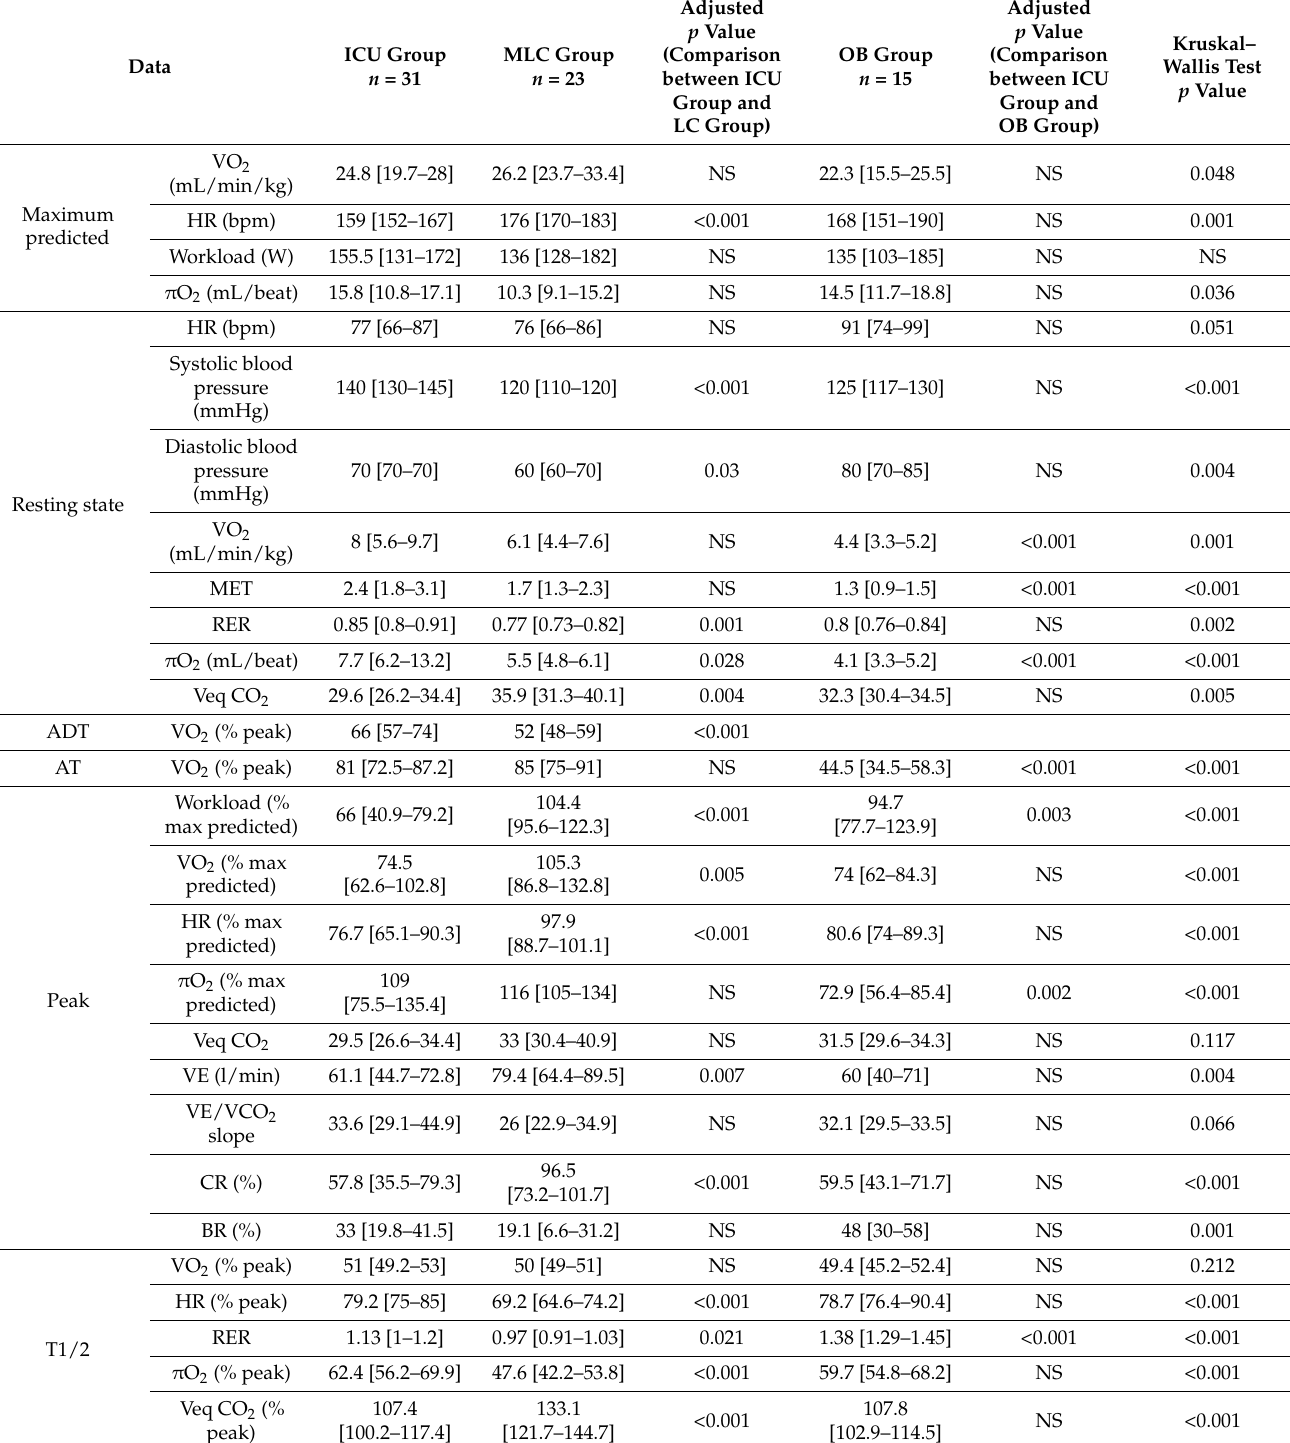
Table 3. CPET data in the three groups of